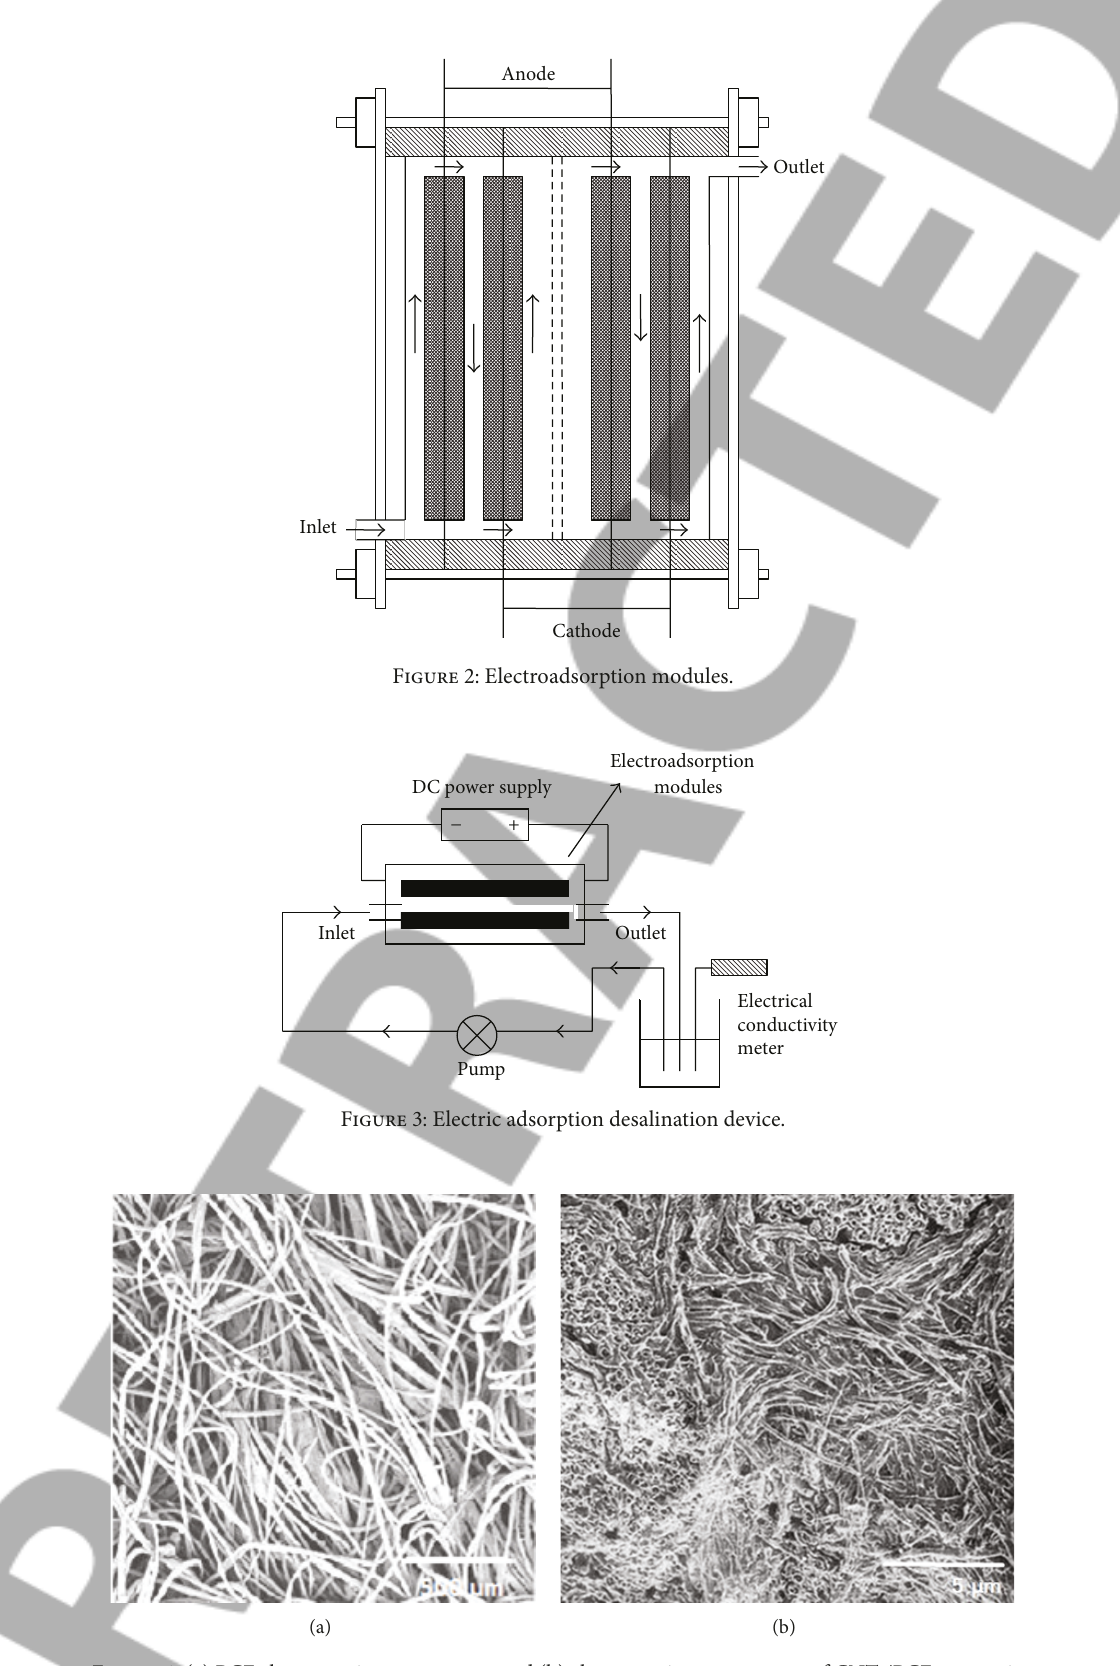
Figure 4: (a) PCF electron microscopy scans and (b) electron microscopy scans of CNTs/PCF